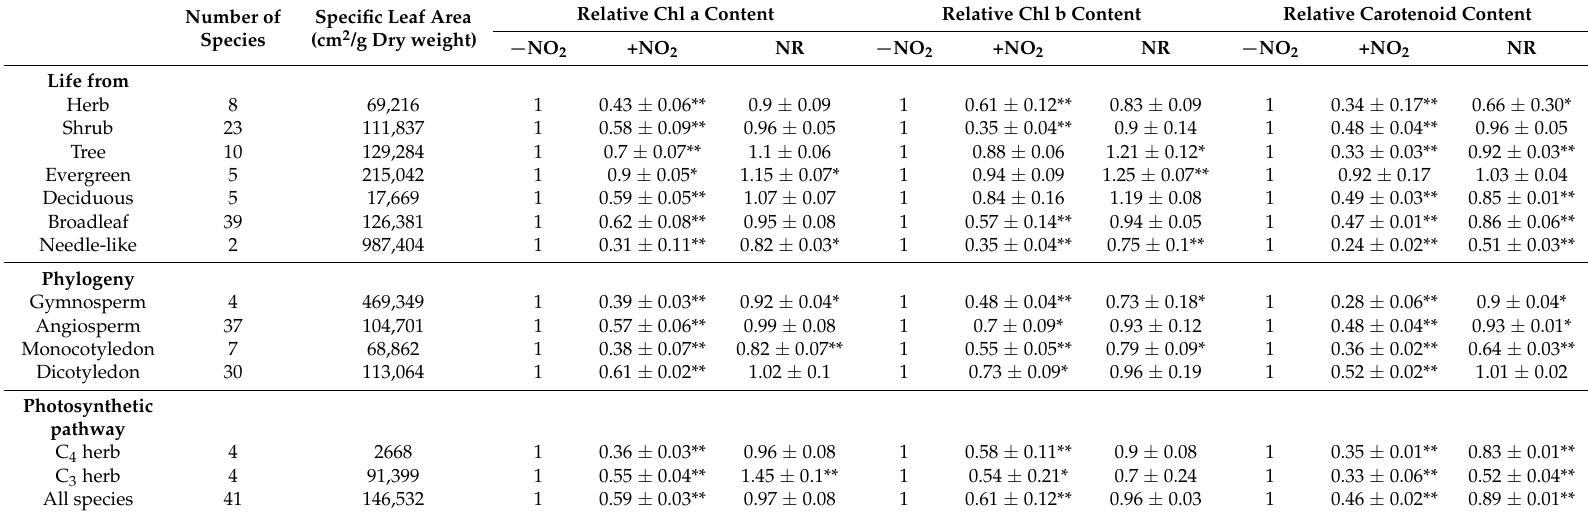
Table 2. Relative leaf chlorophyll (Chl) a content, Chl b content and carotenoid contents (folds) in different plant functional groups treated without nitrogen dioxide (NO 2 ) ( − NO 2 ), with 72 h NO 2 stress (+NO 2 ) or after 30 d of natural recovery